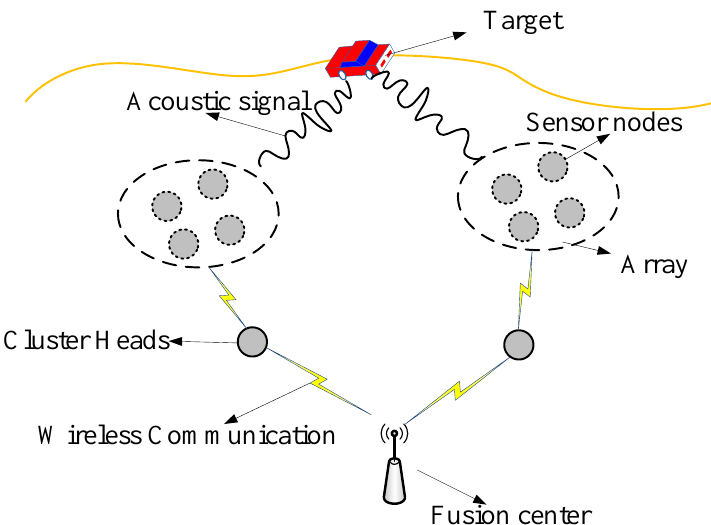
Figure 1. Illustration of the target-tracking